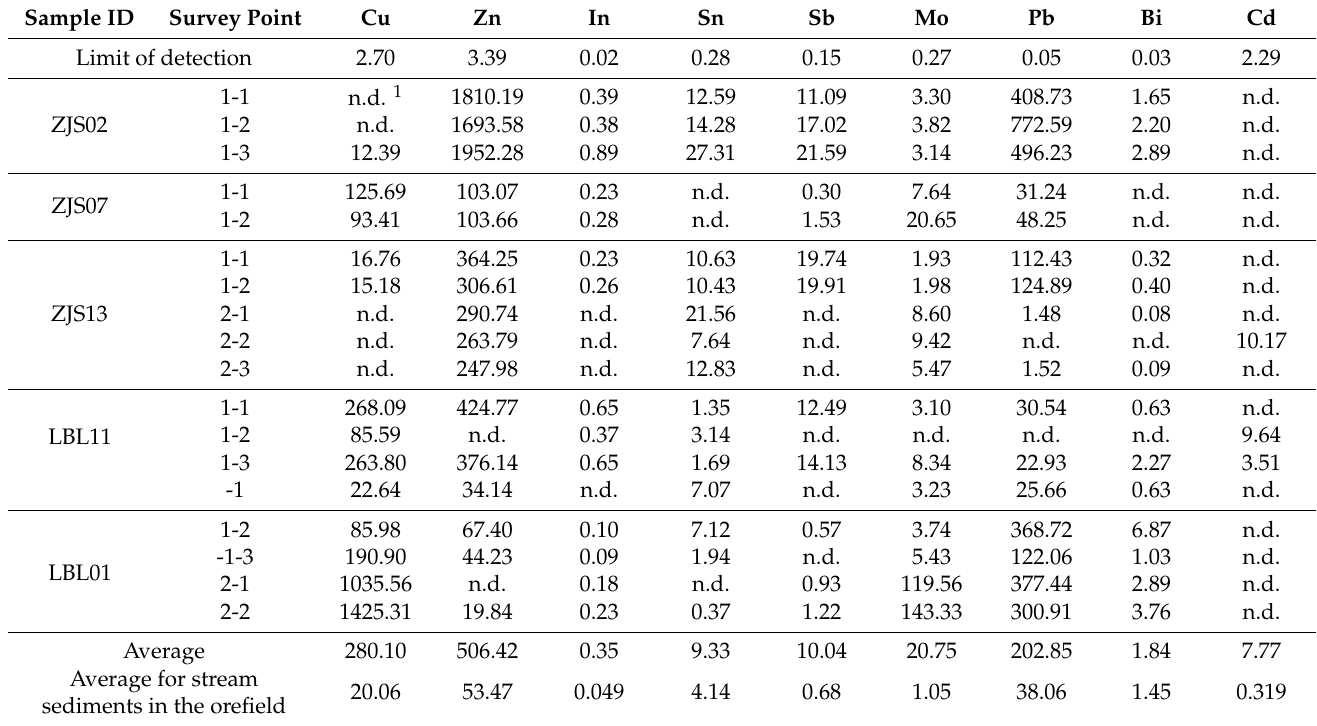
Table 4. LA-ICP-MS trace element analysis of iron oxides in stream sediments (unit: